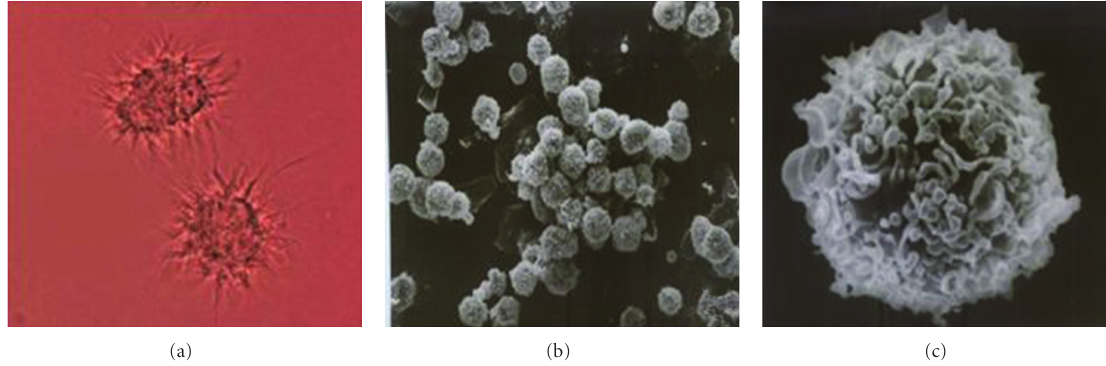
Figure 1: BM-DCs detected by inverted microscope and scanning electron microscope. Progenitor cells were propagated in the presence of rmGM-CSF. After TNF- α and donor antigen addition, the cells show significant di ff erentiation with typical DC appearance under inverted microscope (a) and scanning electron microscope (b) and